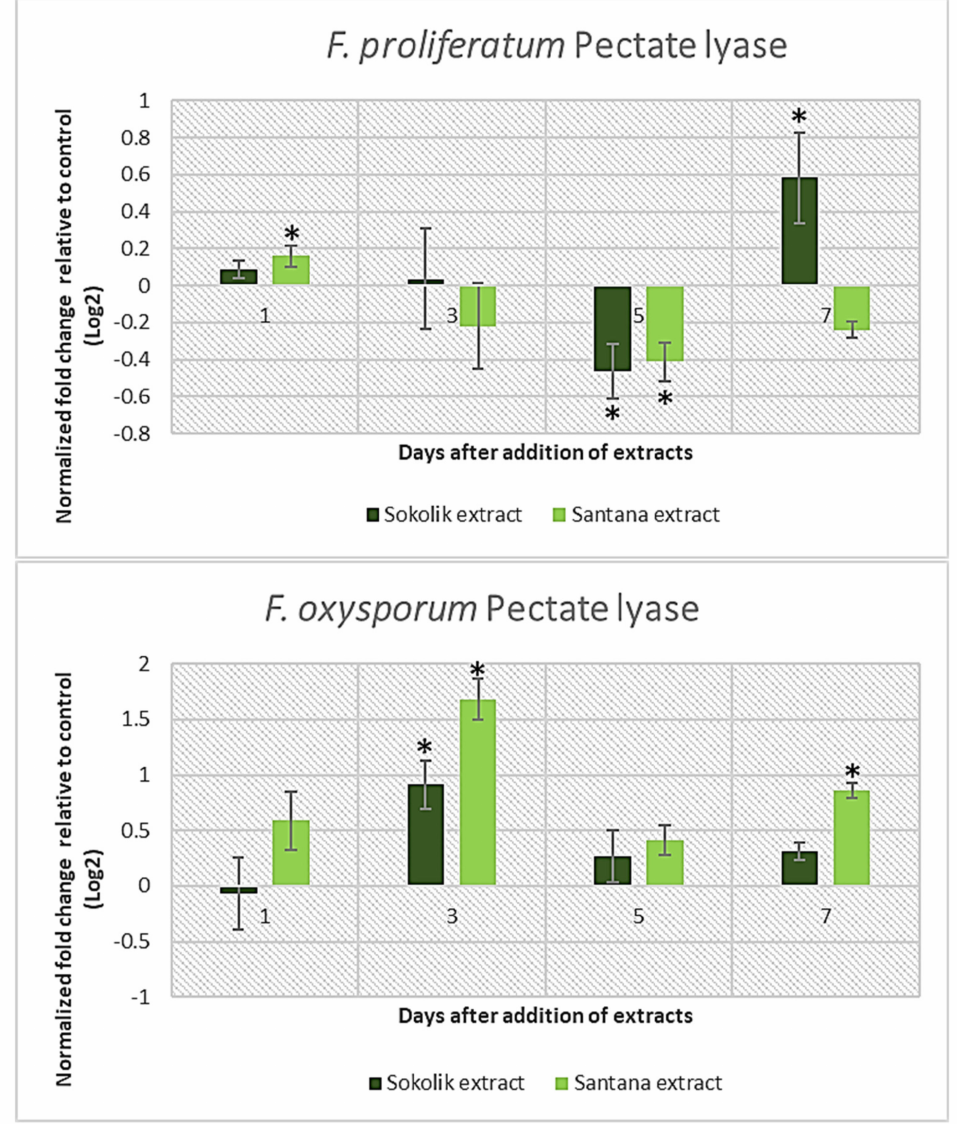
Figure 3. Pectate lyase gene expression of F. proliferatum (PEA1) and F. oxysporum (1757 OX) from day 1 to day 7 after the addition of the Sokolik and Santana extracts. Error bars represent the standard error. * Statistically significant ( p <